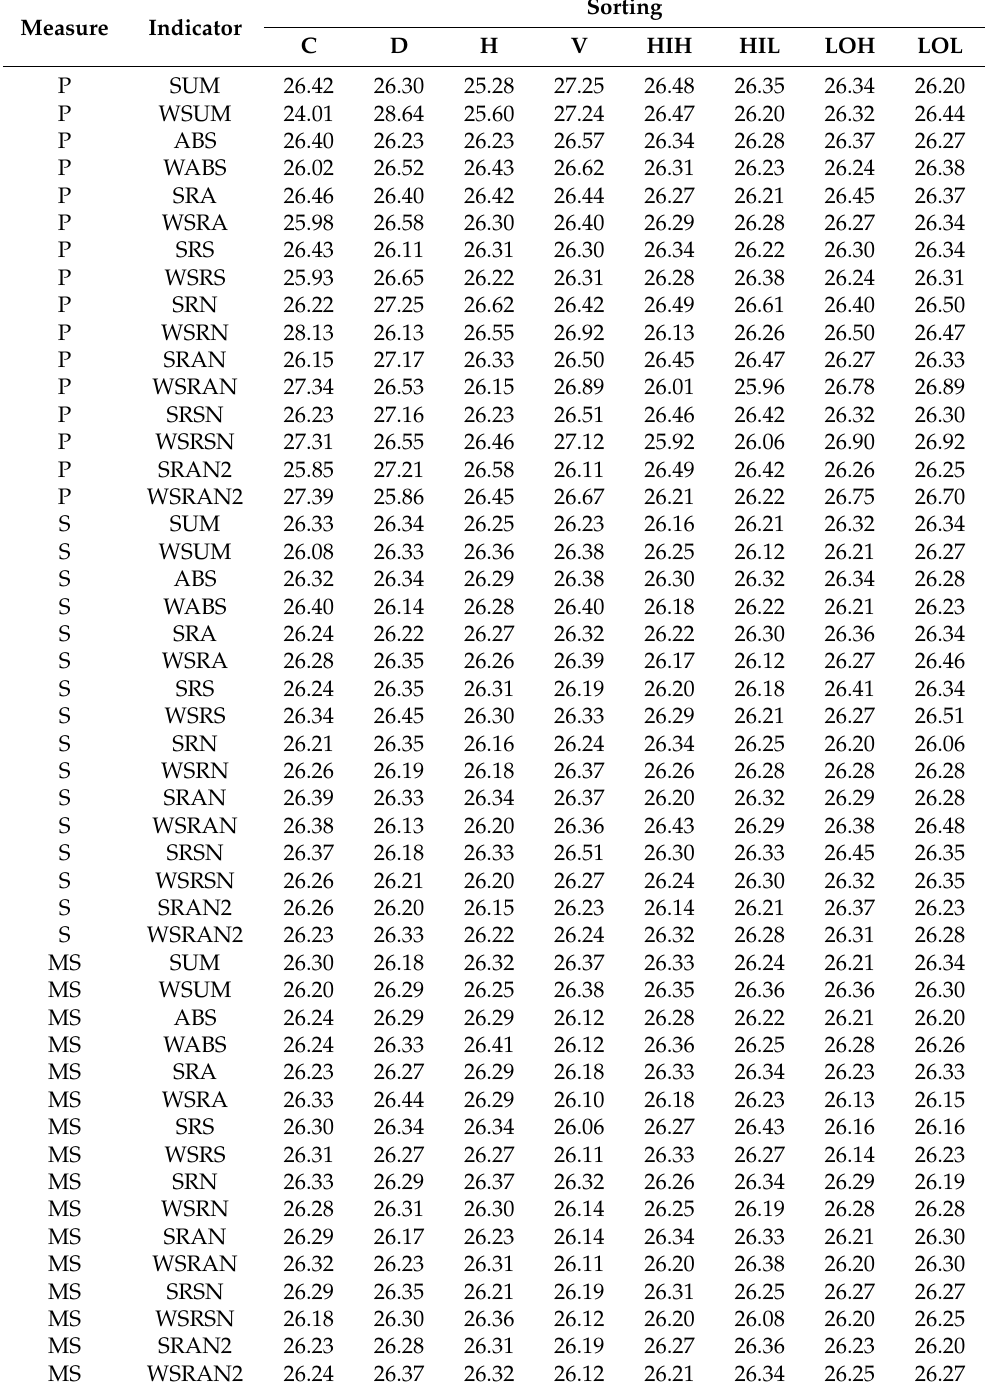
Table 5. Computational results for the dispatching rules: ARPD values